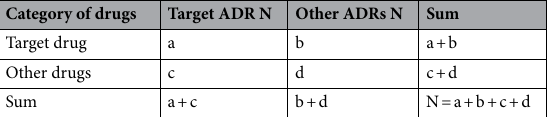
Table 1. The fourfold table used in measures of